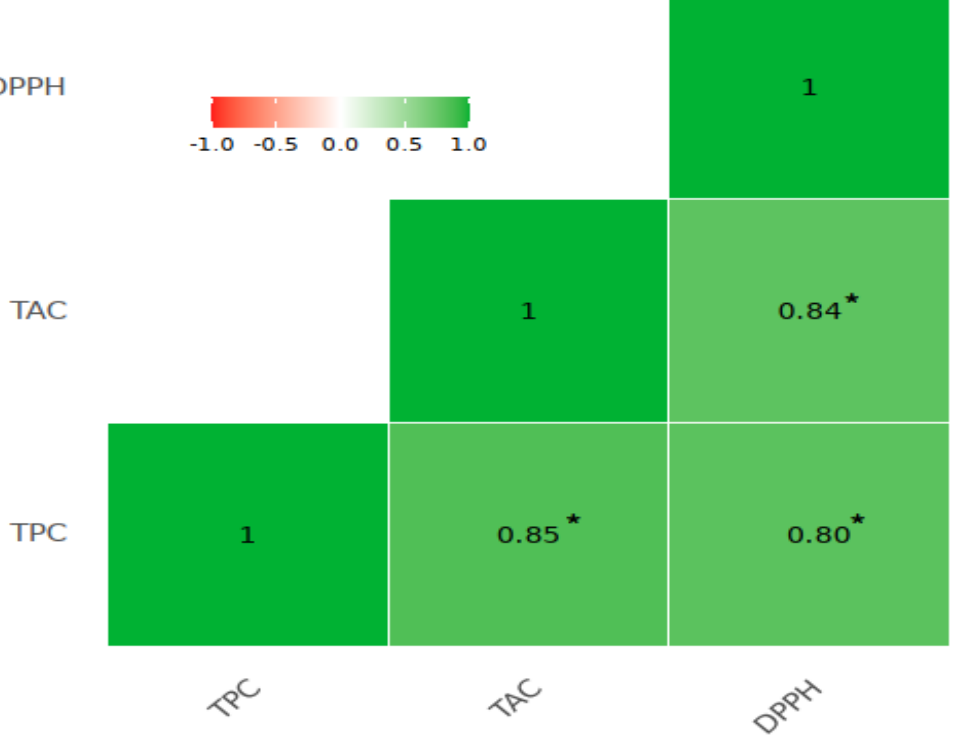
Figure 1. Heatmap shows the correlation between total phenolic content (TPC), total anthocyanin content (TAC), and 2,2-diphenyl-1-picrylhydrazyl (DPPH). * Statistically significant at p < 0.01.